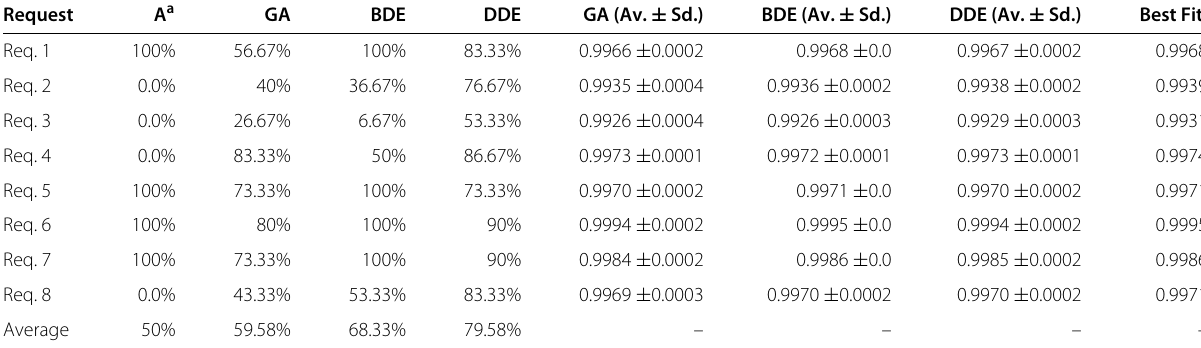
Table 9 Hit percentage results for 200 CPs with arbitrary price decrease (single global optimal) Request